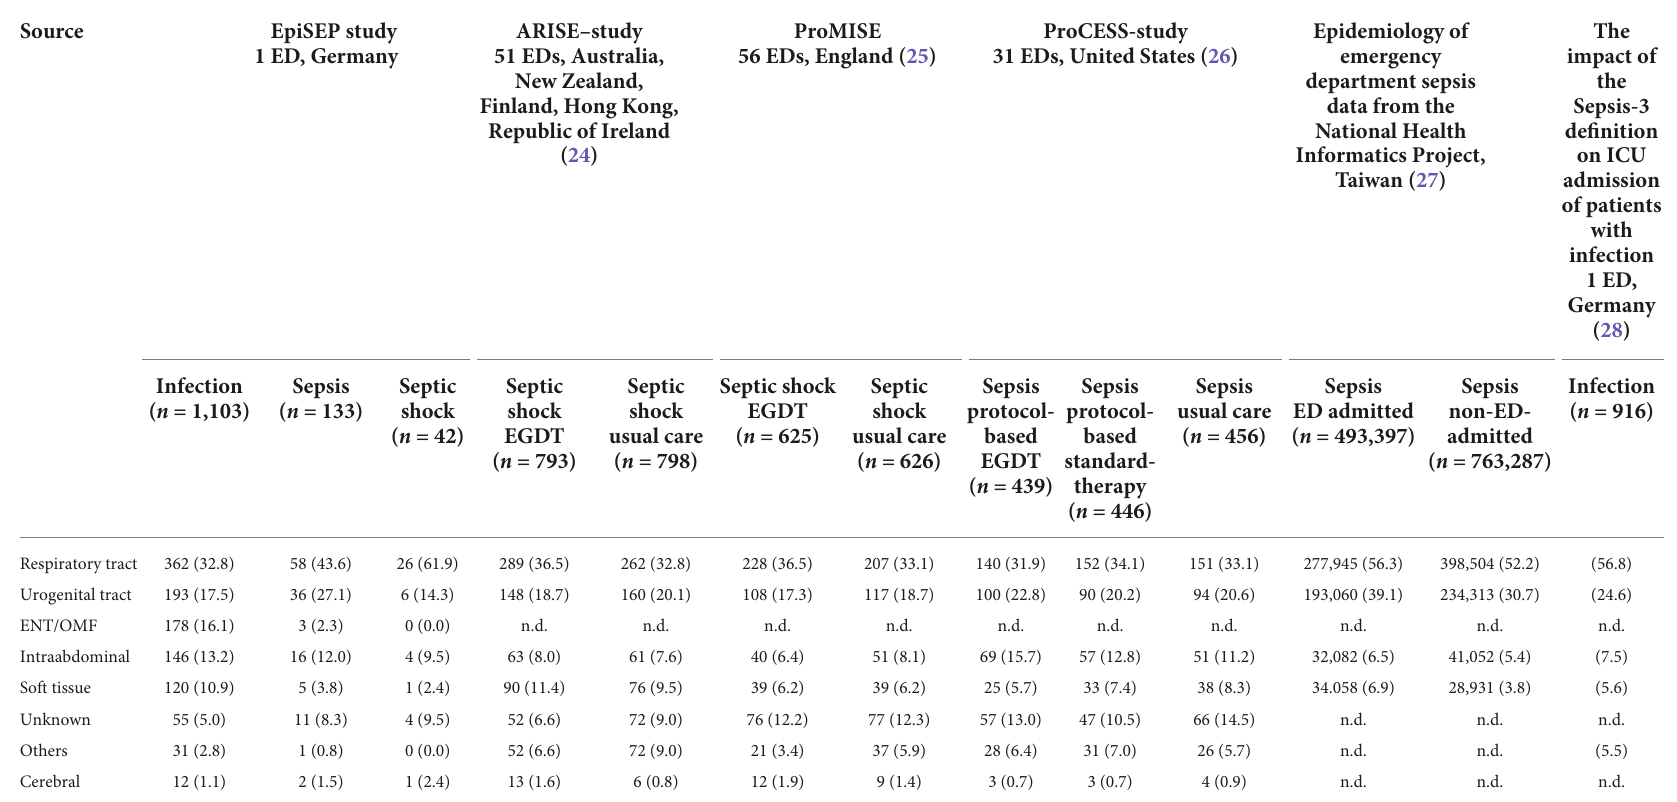
TABLE 5 Comparison of EpiSEP study with studies from emergency department on epidemiology and causes of infection, sepsis, and septic shock.